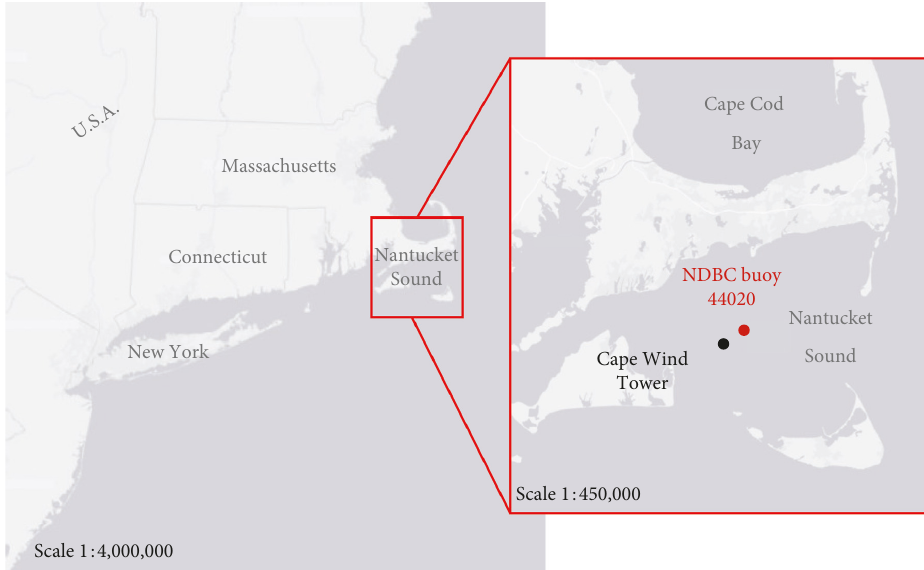
Figure 1: Location of the Cape Wind tower and the National Data Buoy Center (NDBC) buoy 44020 in the Nantucket Sound area off the coast of Massachusetts.